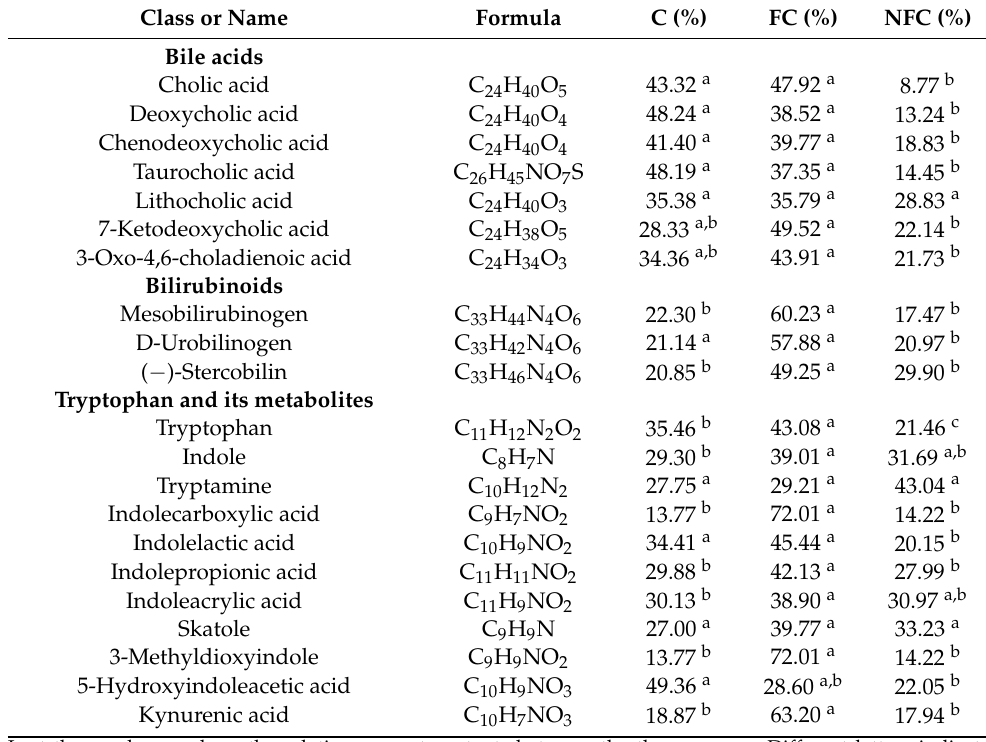
Table 2. Annotation results of differential and their related metabolites from cecal